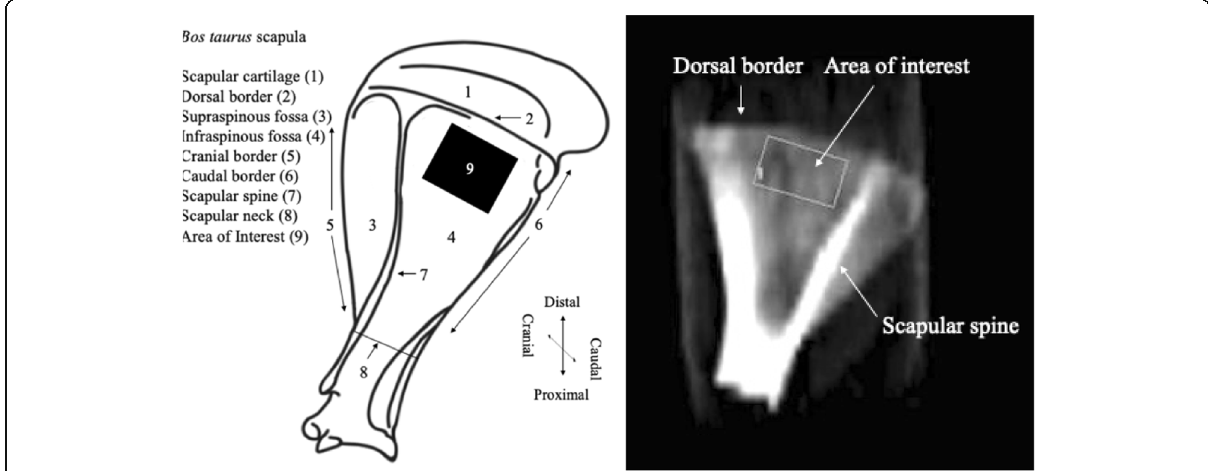
Fig. 2 (Left) Bos taurus scapula. (Right) DXA scan of Bos taurus